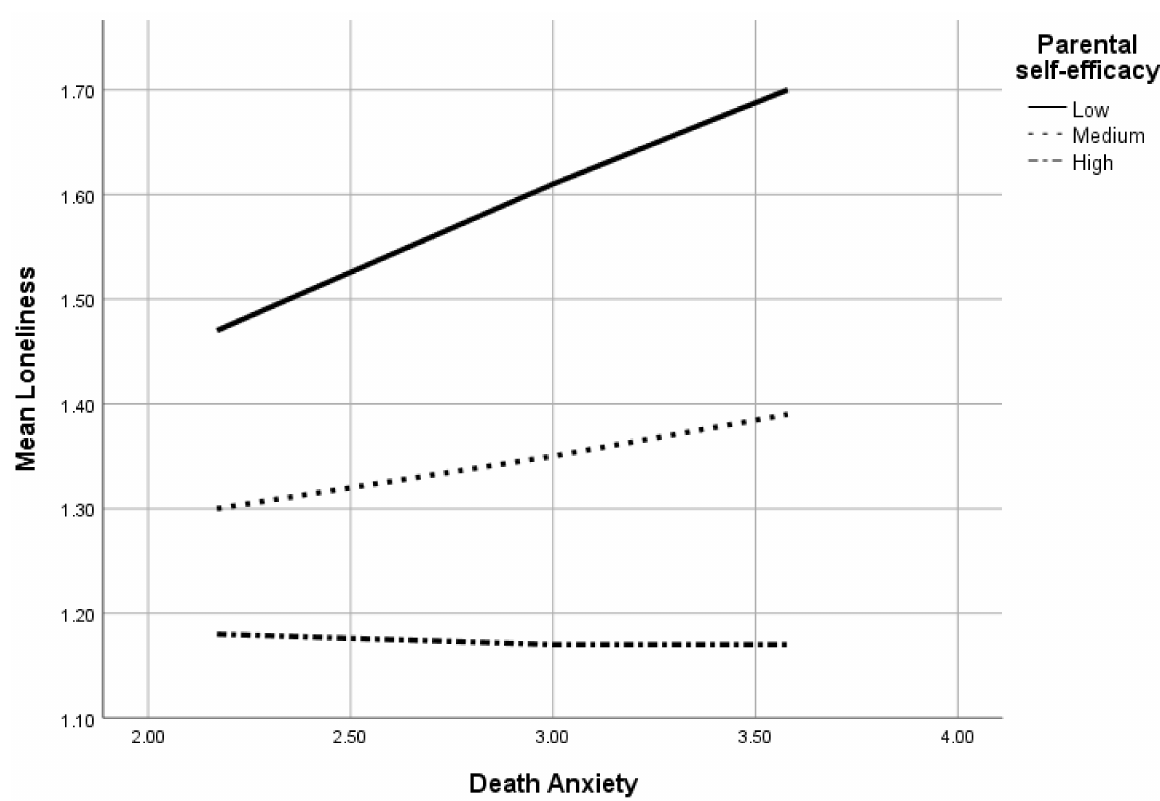
Figure 1. The moderating role of parental self-efficacy in the association between death anxiety and